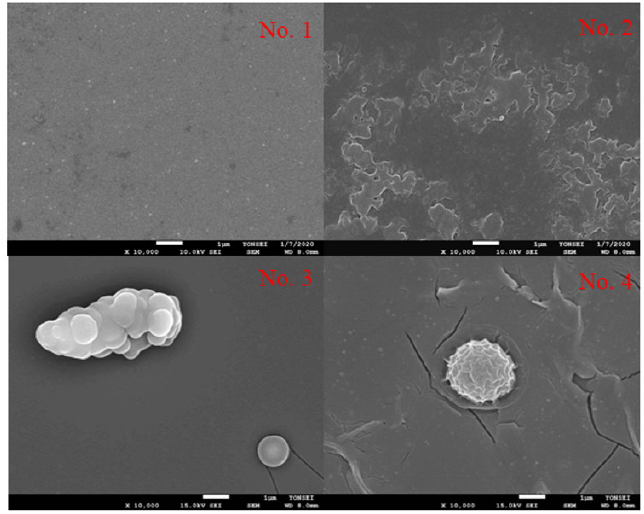
Figure 2. SEM images of the prepared catalytic electrode surface by plasma deposition (see Table 1).